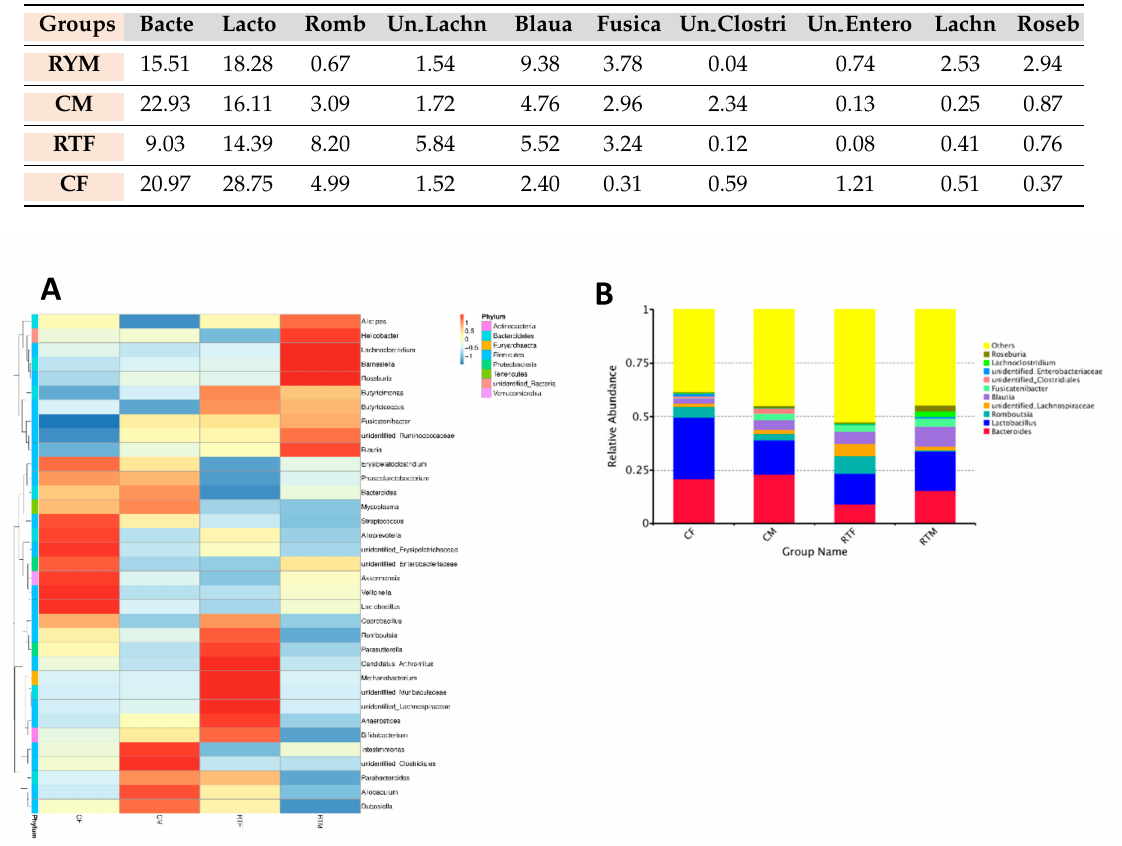
Figure 3. The top ten genera proportions in each group. ( A ) Cluster heat map of the gut microbiota at the genus level, ( B ) relative abundance histogram of the gut microbiota at the genus level. Cold female (CF), cold male (CM), room temperature female (RTF), and room temperature male (RTM).